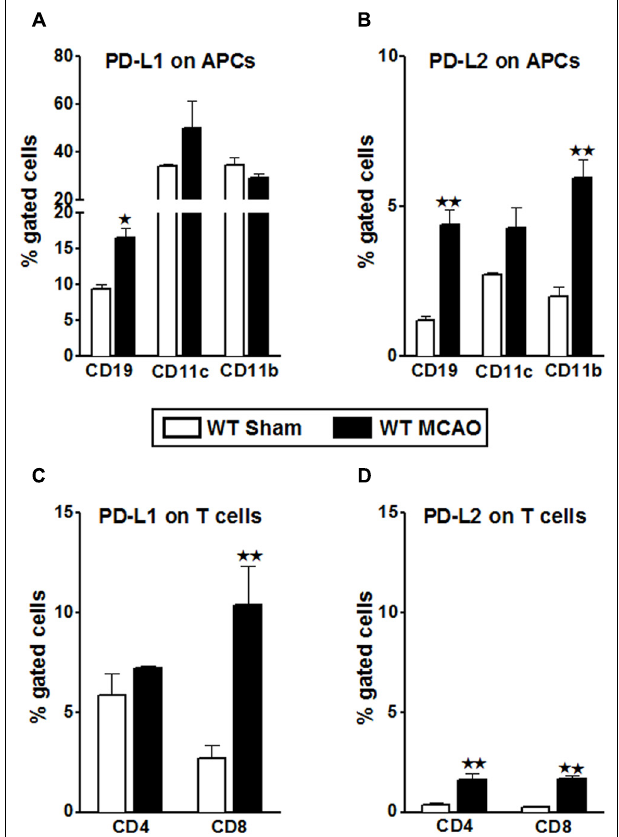
FIGURE 7 | Characterization of PD-L1 and PD-L2 expression onT-cells and antigen presenting cells ofWT splenocytes, post-MCAO. Splenocytes from sham- and MCAO-subjectedWT mice were harvested 96 h after MCAO (60 min) and assessed for expression. (A) PD-L1 and (B) PD-L2 on APCs; gated on CD19 + , CD11b + , and CD11c + cells. (C) PD-L1 and (D) PD-L2 on gated CD4 + and CD8 + T-cells.Values represent mean numbers ( ± SEM) of indicated cell subsets, gated on live leukocytes (by PI exclusion) from 4–5 mice of each group, from two separate experiments. Statistical analysis was performed using Student’s t- test. Significant differences between sample means are indicated as * p ≤ 0.05 and ** p ≤ 0.01 as compared to the sham-treatedWT